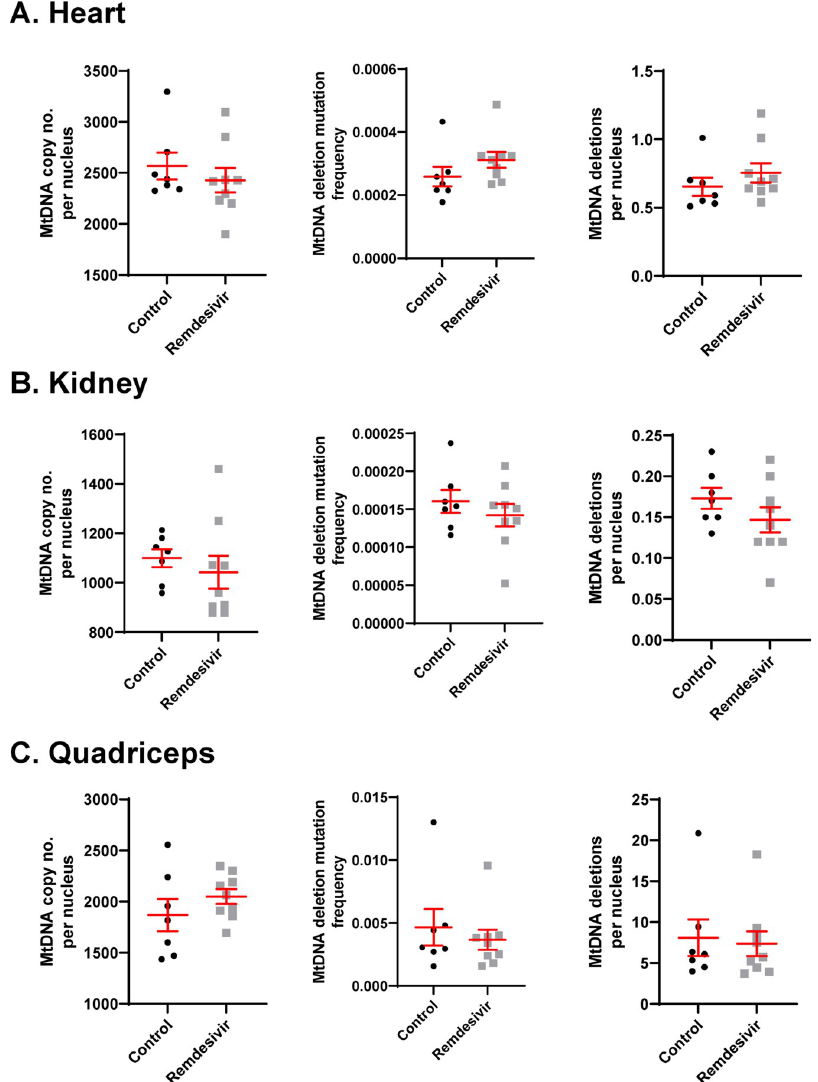
Fig 3. Effects of three months of remdesivir treatment on mtDNA copy number, deletion frequency, and deletions per nucleus in 33-month-old hybrid rats. A. heart, B. kidney, and C. quadriceps muscle. Deletion frequency and deletions per nucleus correspond to interrogation of the major arc of the mitochondrial genome as demonstrated in Fig 1B. Whisker plots denote mean and SEM. Black circles denote control rats, grey squares denote remdesivir-treated rats. N = 7–9 per experimental